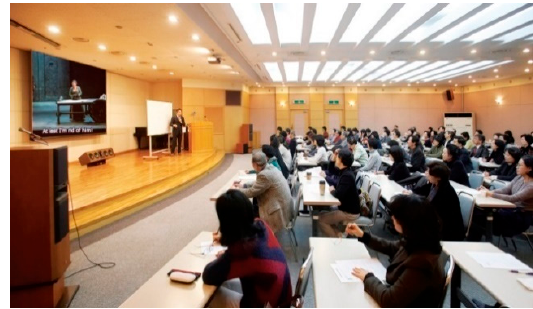
Figure 2. Scene of music appreciation class.